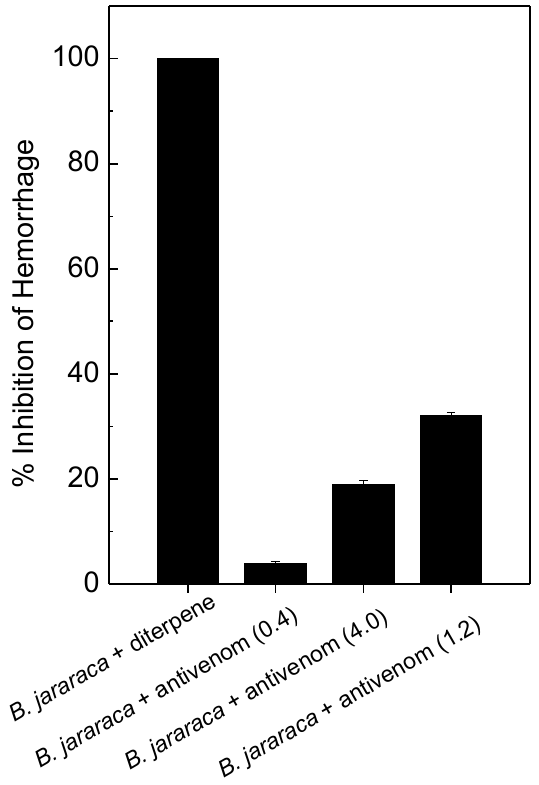
Figure 3. B. jararaca venom (3 µ g/g) was incubated for 30 min at room temperature with a mixture of diterpenes (87 µ g/mL) or with antibothropic serum (antivenom) at 0.4 mL/mg, 1.2 mL/mg or 4.0 mL/mg. Then, hemorrhagic activity was assayed, as described in